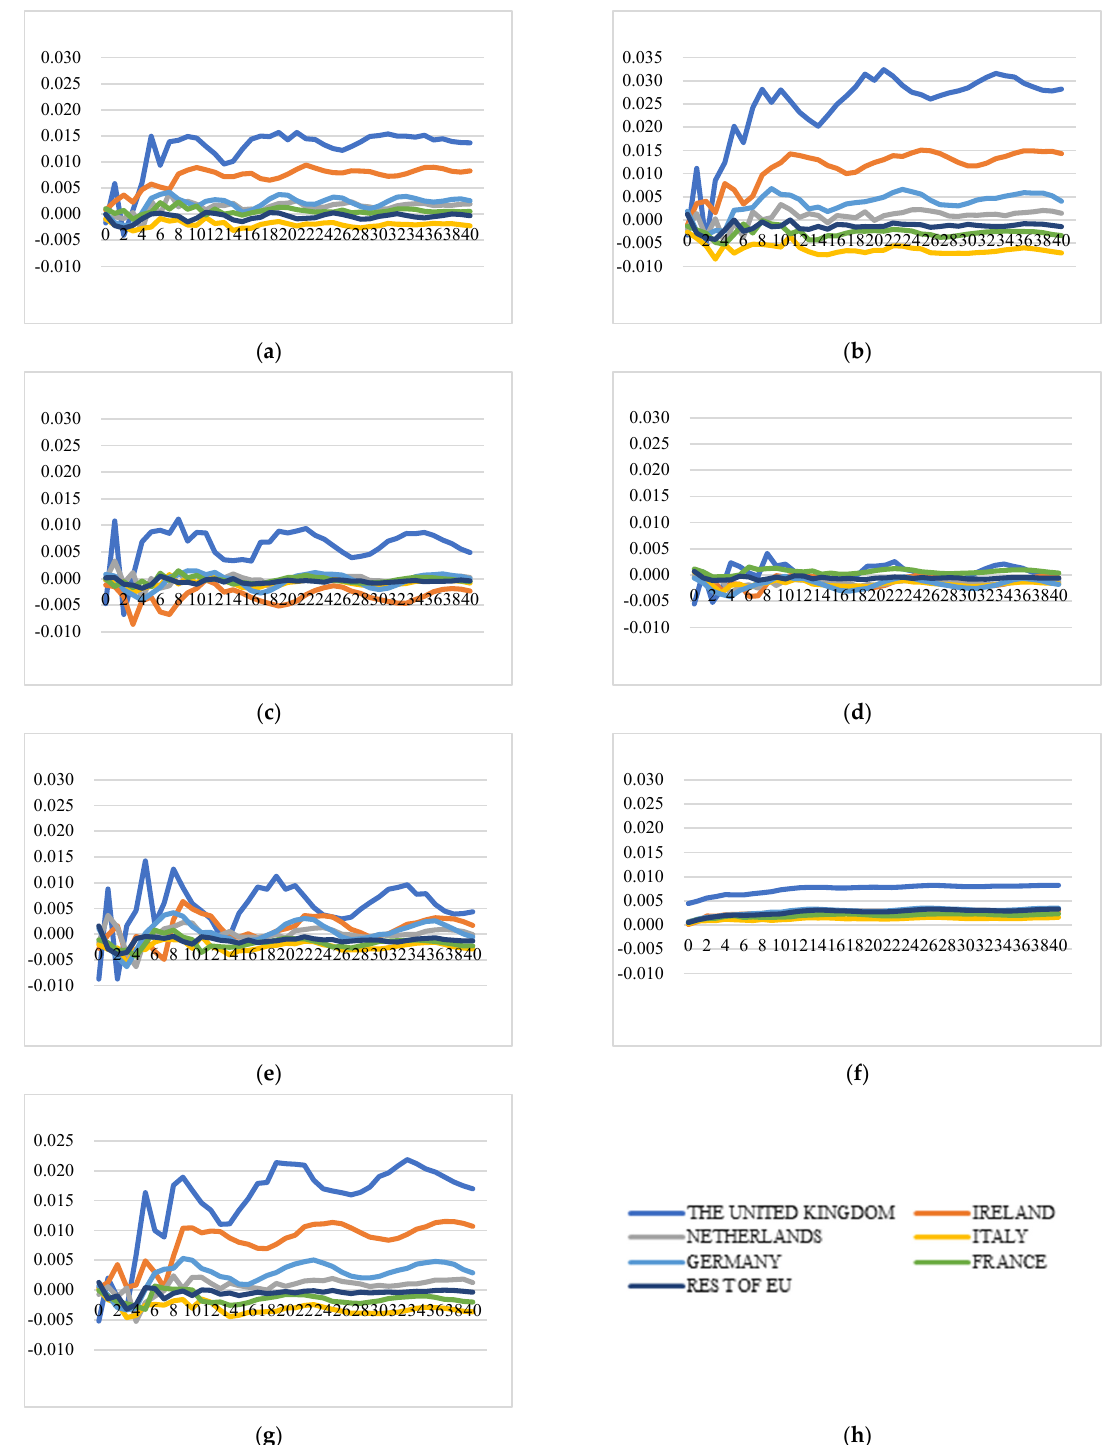
Figure 12. Generalized impulse response functions (GIRFs) of six EU member states’ extra-EU cheese export prices after a positive one-standard-error shock to the Harmonised Index of Consumer Price (HICP) of food (bootstrap median estimates). ( a ) GIRFs after a shock to France’s CPI. ( b ) GIRFs after a shock to Germany’s CPI. ( c ) GIRFs after a shock to Ireland’s CPI. ( d ) GIRFs after a shock to Italy’s CPI. ( e ) GIRFs after a shock to the Netherlands’ CPI. ( f ) GIRFs after a shock to the UK’s CPI. ( g ) GIRFs after a shock to the rest of the EU’s CPI. ( h )